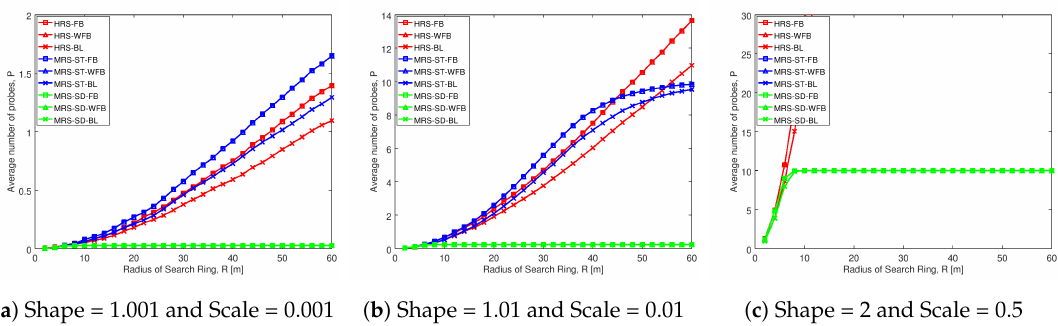
Figure 7. Average probe number comparison of various schemes in different social trust scenarios when network width is 100